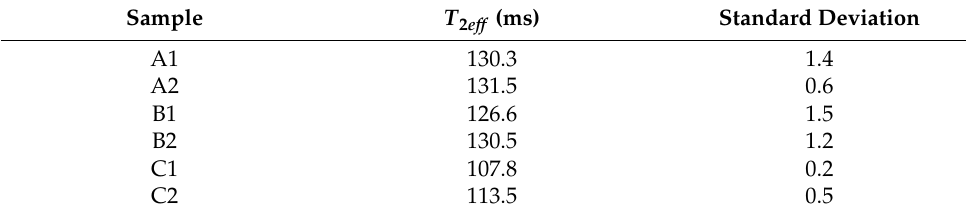
Figure 15. ( a ) One-dimensional spectral curves of transverse relaxation times of A1 and A2 samples. ( b ) One-dimensional spectral curves of transverse relaxation times of B1 and B2 samples. ( c ) One-dimensional spectral curves of transverse relaxation times of C1 and C2 samples. As seen in Figure 15, the solid line (upper surface) shifts to the left, compared with the dotted line (lower surface), and the trend of the left-shift is gradually clear from Figure 15a – c. It indicates that the upper and lower surfaces of the insulators age differently, and that this difference becomes gradually more obvious as service time increases. The T 2eff of the upper and lower surfaces of different samples are shown in Table 4. After comparison, the T 2eff value of the lower surface of the new insulator changes by approximately 0.93% compared with the upper surface, which is within the measurement error of the sensor, and it is difficult to distinguish the upper and lower surfaces of the insulator by data comparison. The T 2eff values of the lower surface of insulators that have been in operation for 2 and 5 years are approximately 3% and 5.08% higher than those of the upper surface, respectively, and it is basically possible to distinguish the upper and lower surfaces from the numerical values. Therefore, the mobile MRI measurement results can reflect the difference in the aging degree between the upper and lower surfaces of the composite insulator shed; the T 2eff values on the upper surface of the aging insulator are smaller than those on the lower surface, and the larger the difference between the T 2eff values on the upper and lower surfaces, the more serious the aging. Table 4. Values of T 2 eff of the samples on the upper and lower surfaces.